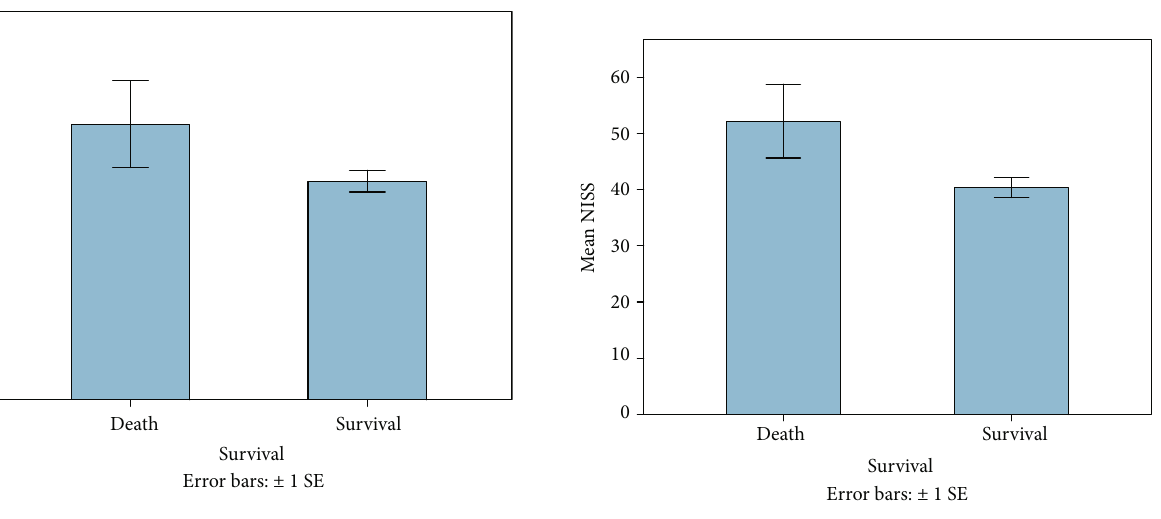
Figure 5: Mean NISS of all patients according to patient ’ s outcome. Patients who died after the traumatic event showed higher mean NISS than those who survived (mean NISS survivors: 40 : 2 ± 12 : 8 SD; mean NISS nonsurvivors: 50 : 5 ± 12 : 2